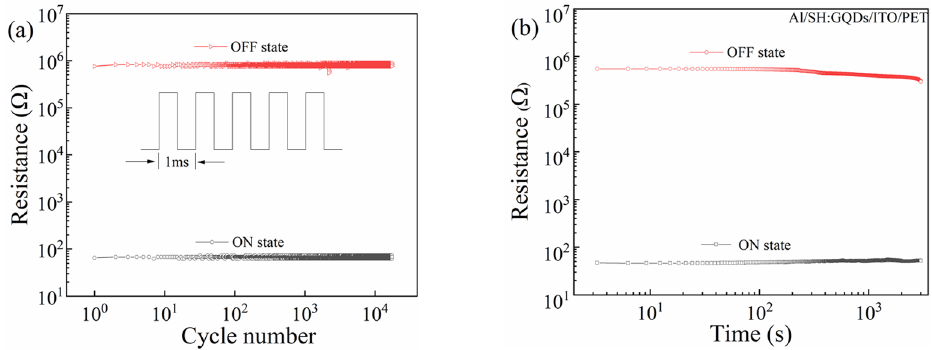
Figure 6. Al/SH:GQD/ITO/PET device: ( a ) pulse test and ( b ) retention time. The ON/OFF current ratio versus voltage curve is shown in Figure 7b, and the maximum ON/OFF current ratio is 6.55 × 10 4